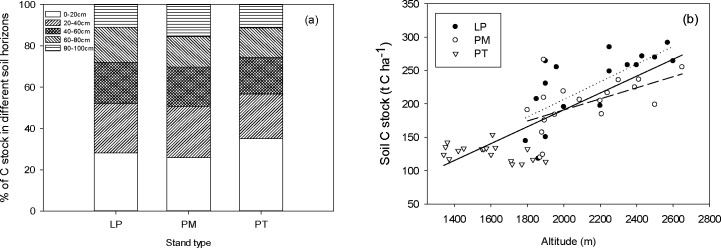
Percentage of C stock in different soil horizons (a) and total soil C stock along the altitudinal gradient (b) in three coniferous forests on the Loess Plateau, China. LP, Larix principis-rupprechtii forest; PM, Picea meyerii forest; PT, Pinus tabulaeformis forest. Solid, long dash and dotted lines represent significant relationships between soil C stock and altitude across the three forests (r2 = 0.61, p<0.001), within LP forest (r2 = 0.49, p = 0.001) and within PM forest (r2 = 0.29, p = 0.021) respectively in (b).